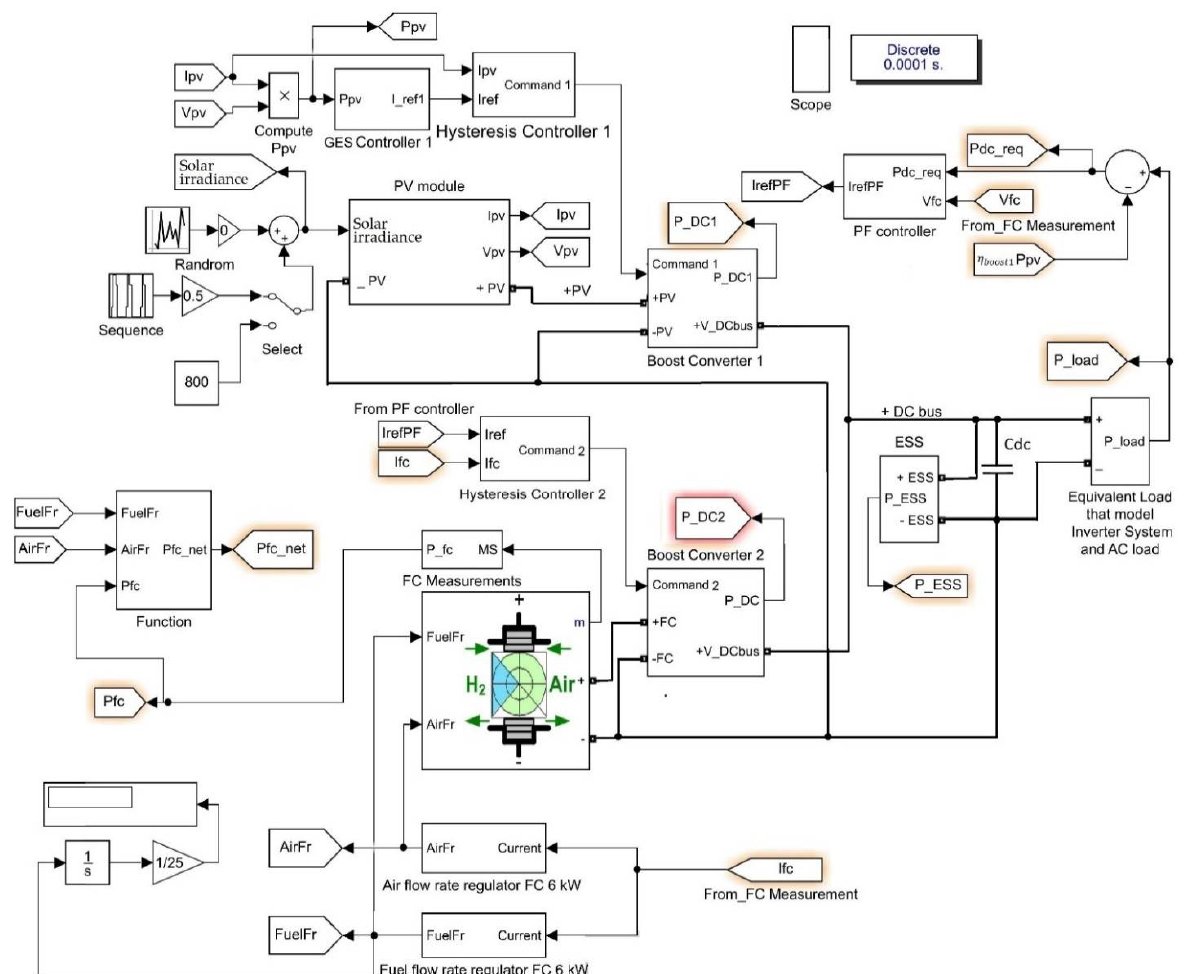
Figure 3. PV/FC/ESS hybrid power system diagram using strategy S0.